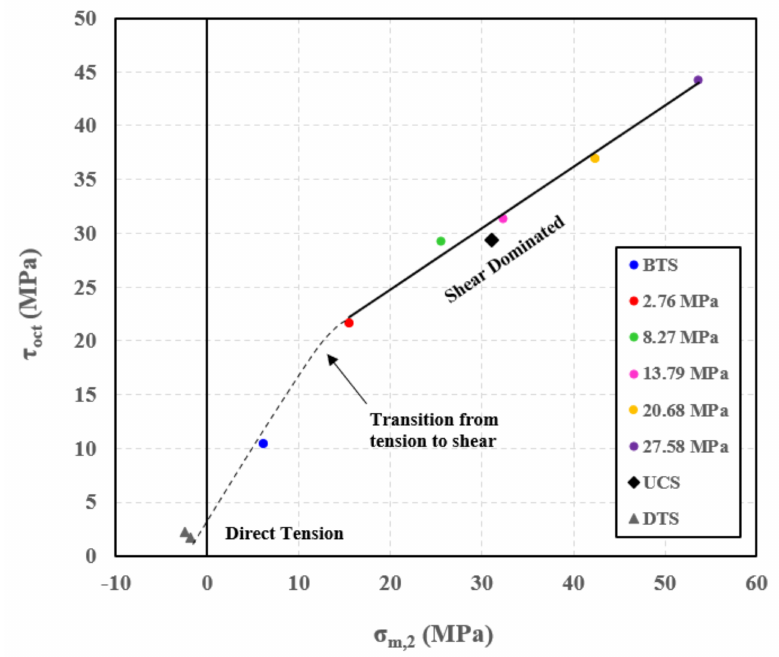
Figure 8. Failure curve represented in σ m,2 vs. τ oct stress space plotted with the average failure stresses at each confining pressure. Note the uniaxial compression failure is consistent with confined Brazilian failure data. The estimated direct tension strength (DTS) range is represented between triangle